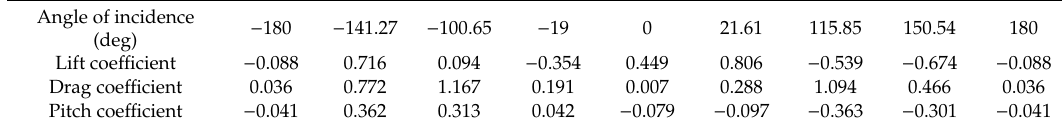
Table A2. Aerofoil parameters of